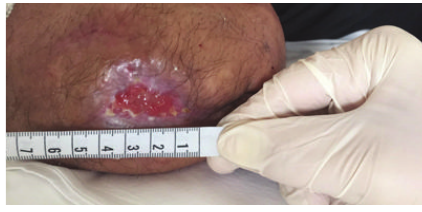
Figure 4: Stage IV at 4th